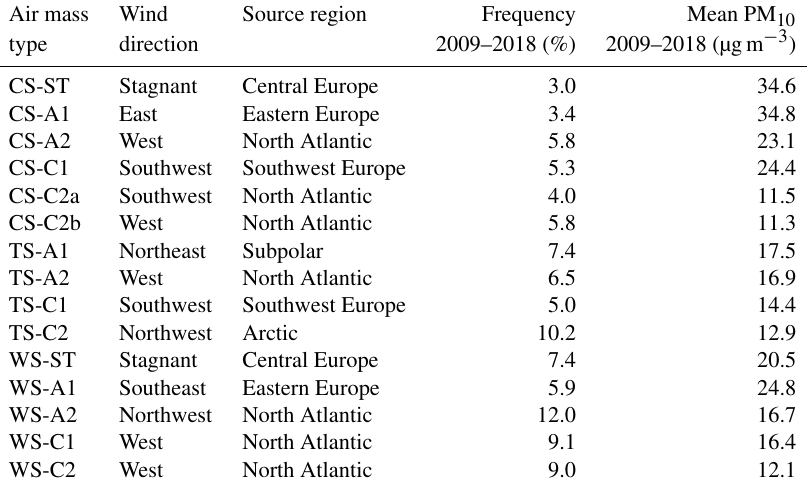
Table 6. Basic statistical information of the 15 air mass